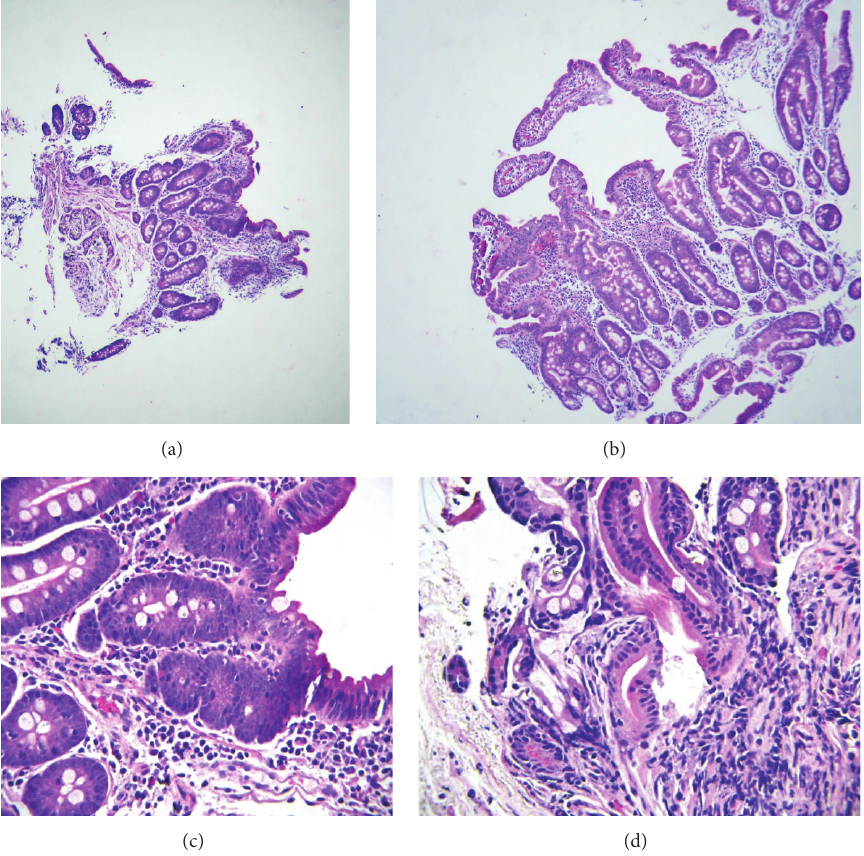
Figure 4: Duodenal mucosa: (a) and (b) moderate to severe shortening of most villi (few rather tall villi are seen in picture (b)). (c) Focal superficial epithelial changes (poor gobletting, irregularity of lining cells) (intraepithelial lymphocytes: under 10/100). There is also mild to moderate infiltration of lymphoplasma cells and some eosinophils (3–7/100) in lamina propria. (d) Note crypt architectural changes.